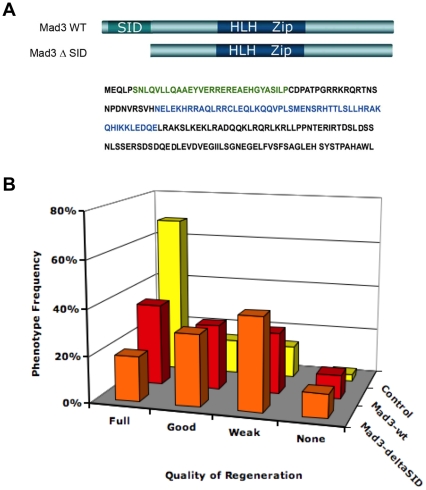
Over-Expression of Mad3 Inhibits Tail Regeneration.(A) Schematic showing the structure of Mad3 protein. Green indicates the Sin3-interacting domain (SID) important for the Mad3 interaction with HDACs. The DNA binding domain is represented in blue. Mad3 WT shows the full-length sequence and Mad3-ΔSID showing the construct that lacks the SID domain. (B) Mad3 WT, Mad3-ΔSID and lacZ mRNA were injected into early embryos at the 4 cell stage. Embryos were allowed to develop until st. 40, when tail amputation was performed. Graph showing effects of ectopic expression of Mad3 WT and Mad3-ΔSID on tail regeneration at 7 dpa. Control regenerates (RI = 250, n = 95). Wild-type Mad3 expression (RI = 188, n = 68, p<0.01). Mad3 with SID deletion expression (RI = 159, n = 88, p<0.01). p value denotes comparison to control. Comparison of the 2 ectopic expression experiments yielded p>0.05.